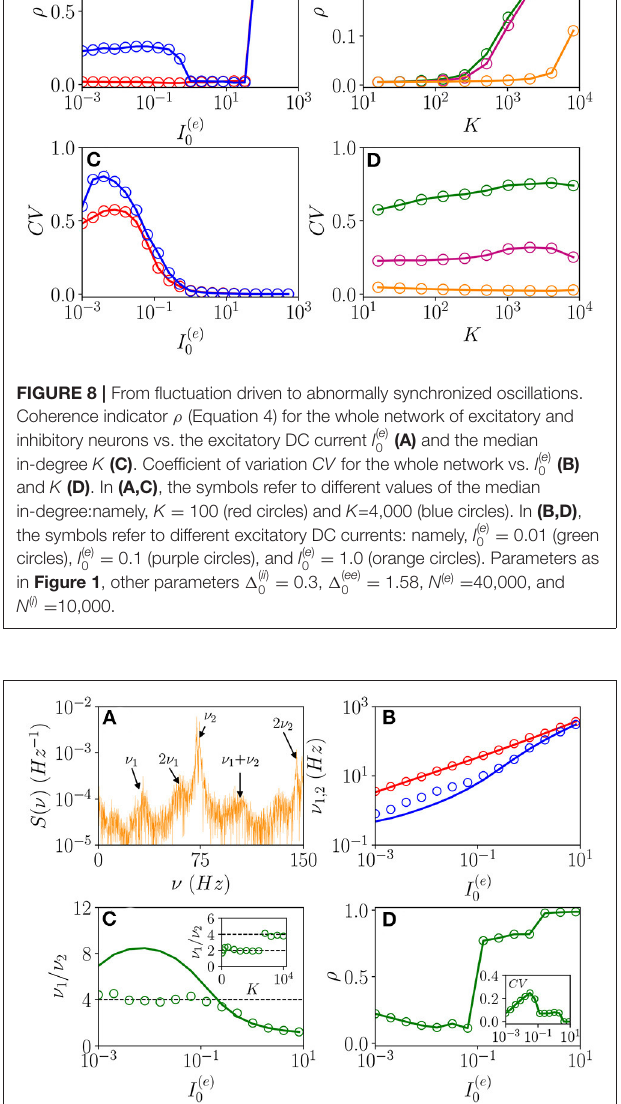
population. However, in Meng and Riecke (2018), the neurons